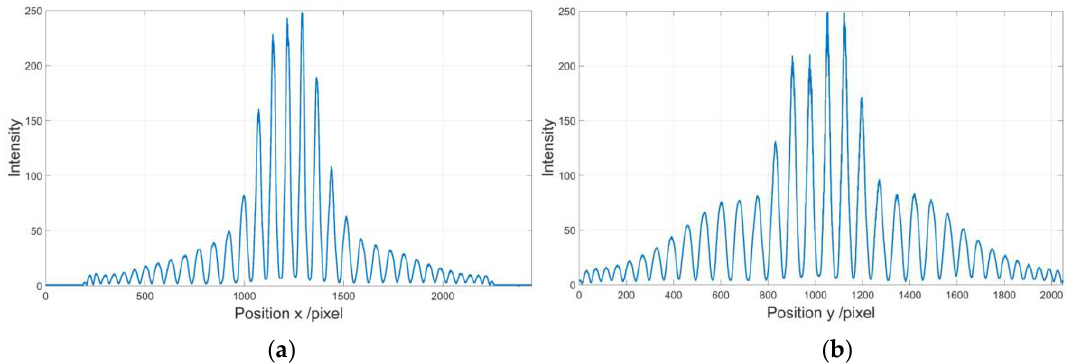
0, π /2, π , 3 π /2 are in the second row. 0, /2, ,3 /2 π π π are in the second row.